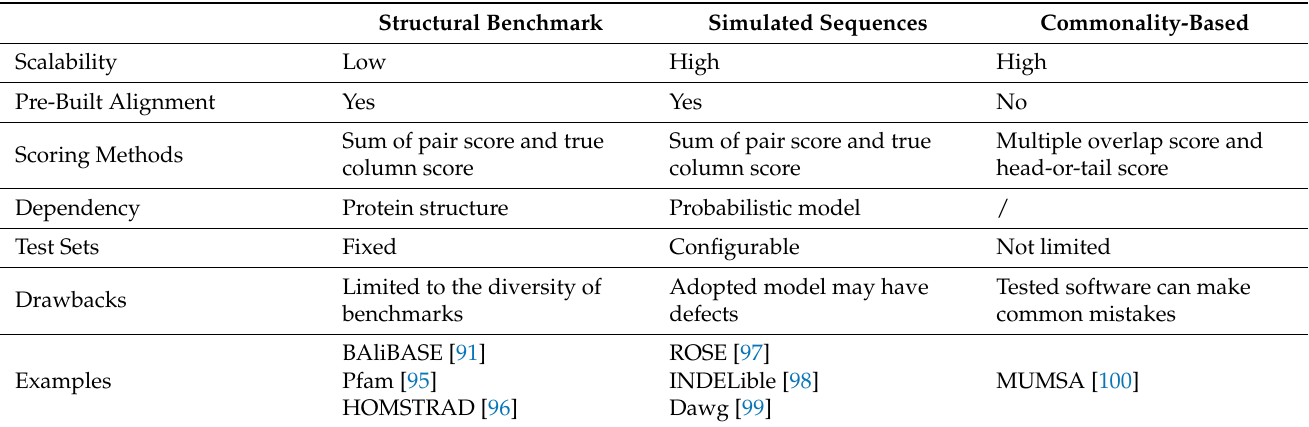
Table 1. Quality estimation methods of multiple sequence alignment software. Structural Benchmark Simulated Sequences